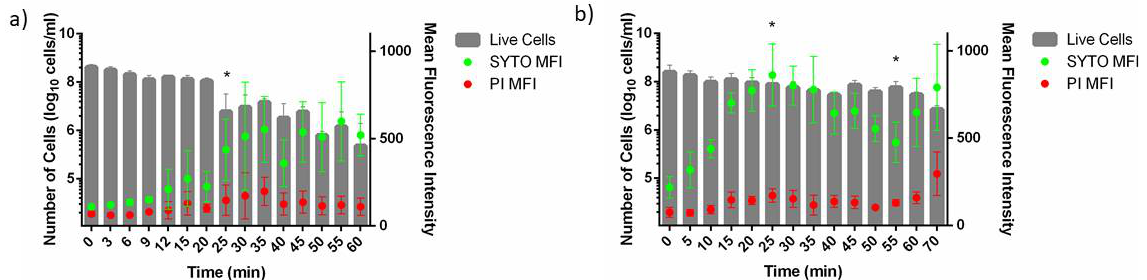
Figure 1. Flow cytometric analysis of P. aeruginosa PAO1 cells infected with ( a ) phage PE3 and ( b ) phage DP1. On the left yy axis are represented the total cell counts and on the right yy axis the median intensity fluorescence of SYTO and PI. Values represent the mean plus or minus standard deviation of four independent experiments performed in duplicate. Statistical differences (* p < 0.05) were analyzed using ANOVA with Tukey’s honest significant difference post hoc test.